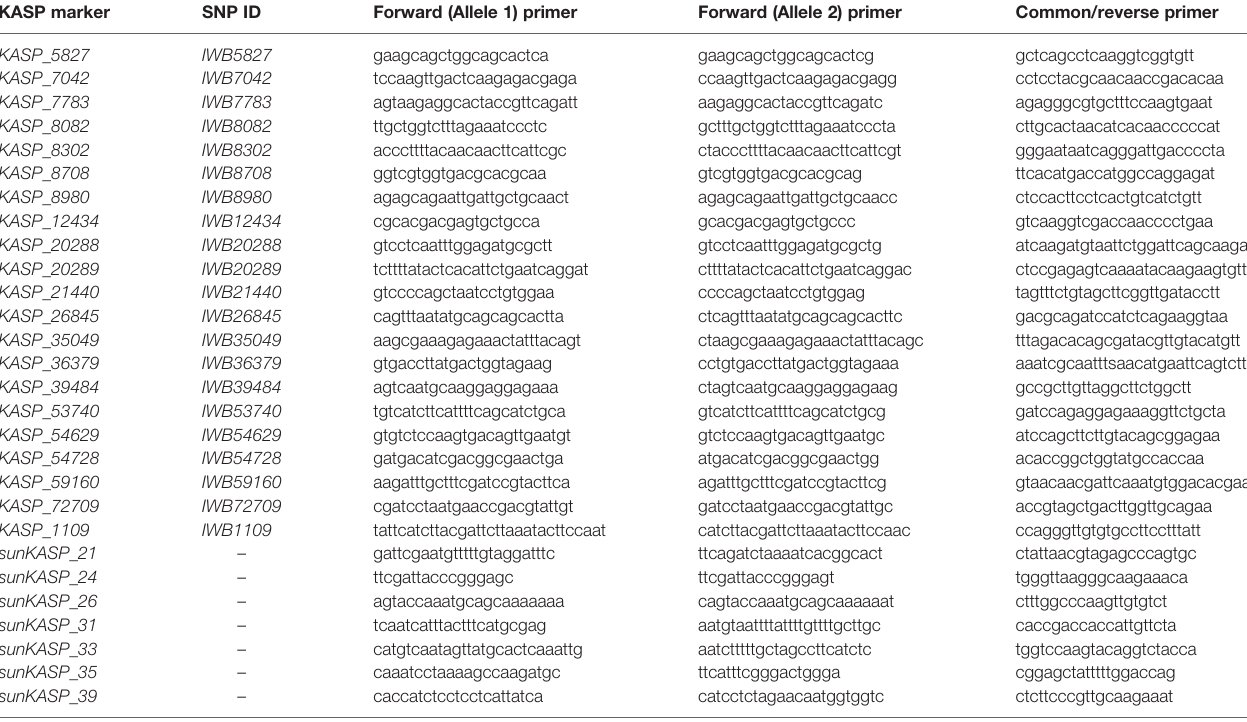
TABLE 1 | Primer sequences for kompetitive allele-speci fi c PCR (KASP) markers designed from SNP sequences that showed association with Lr49 on chromosome 4BL and SNPs discovered from the sqeuences of fl ow sorted chromosome 4B of parental genotypes. KASP